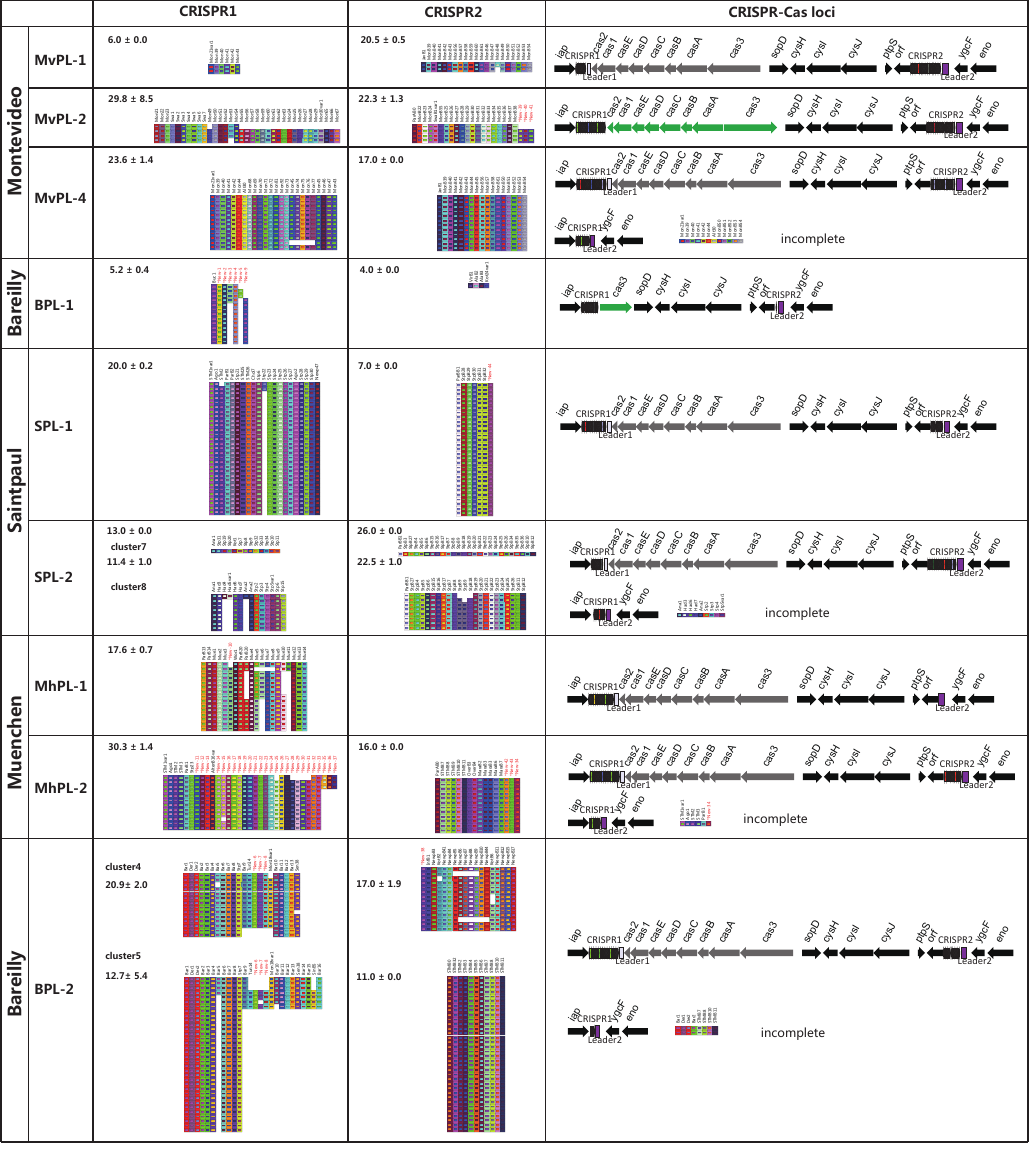
Figure 7. Structures of CRISPR-Cas systems from Montevideo, Bareilly, Saintpaul, and Muenchen. The organizations of the CRISPR-Cas system in each lineage is arranged in the order of the core genome tree. The cas genes of the LT2 subtype are represented by the grey arrows, and the ty2 subtype is represented by the green arrows. Leader1 is represented by the white square, and the purple square represents Leader2. Colored squares under the gene clusters represent spacer organization. Spacers of the same color and symbols indicate sequence consistency. The values shown are the mean ( ± SD) number of spacers per array. The known and new spacers are marked with the spacer ID in Institut Pasteur and asterisk, respectively. The new spacers also are indicated in red. The di ff erent BAPS clusters in an individual lineage are labelled. Samples are in the same order as they are in the core genome tree (Figure